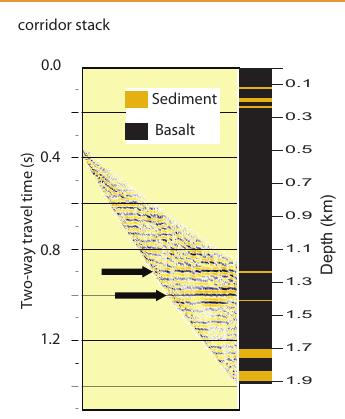
Figure 8. Processed vertical seismic profile from the Kimama 1B borehole. Two strong reflectors associated with sediment interbeds at 900 m and just below 1000 m depth are highlighted by